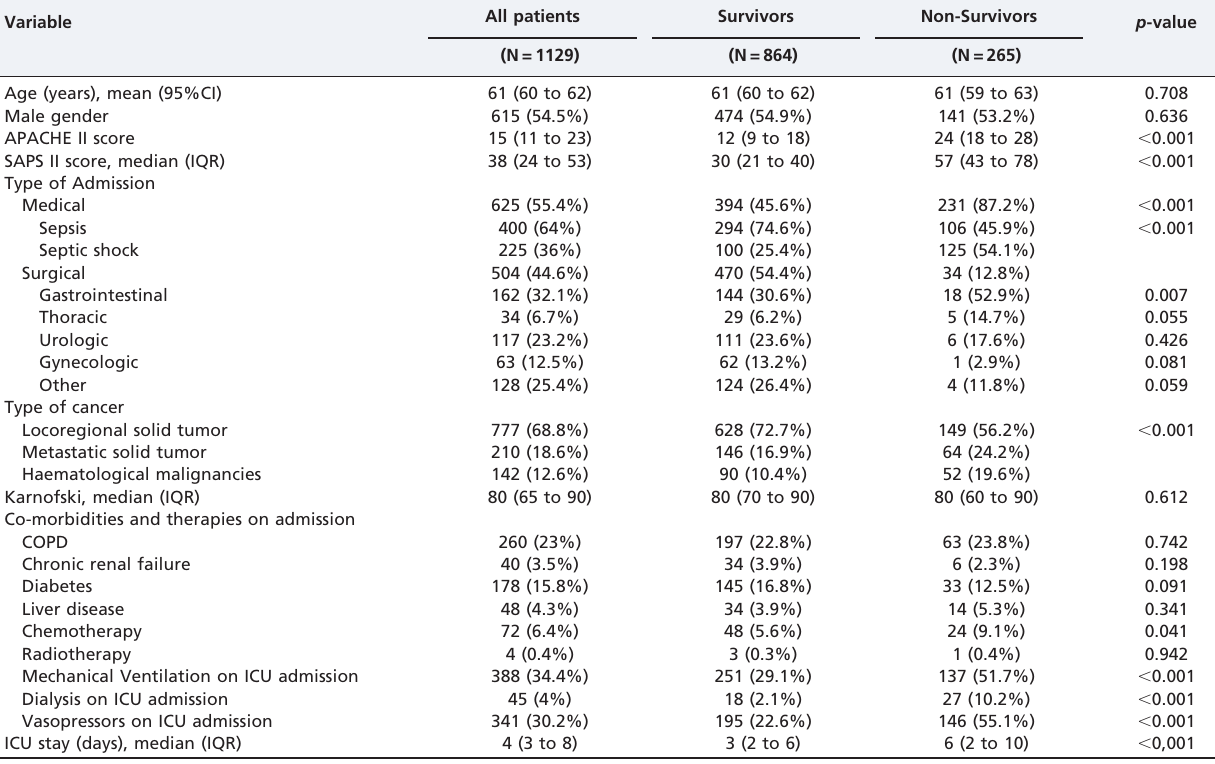
Table 1 - Demographic and clinical characteristics of the patients and their outcomes. Variable All